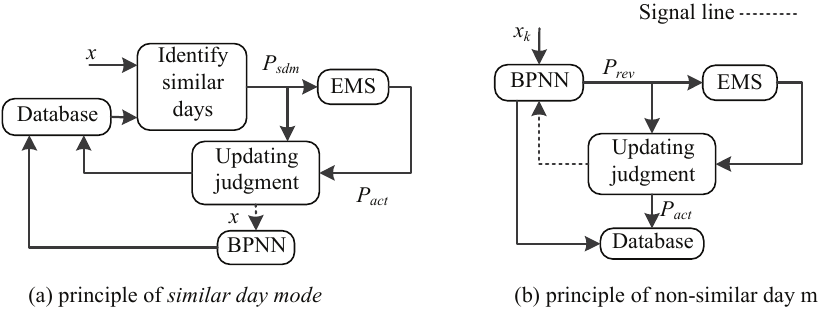
Figure 3. The ASPF schematic in different